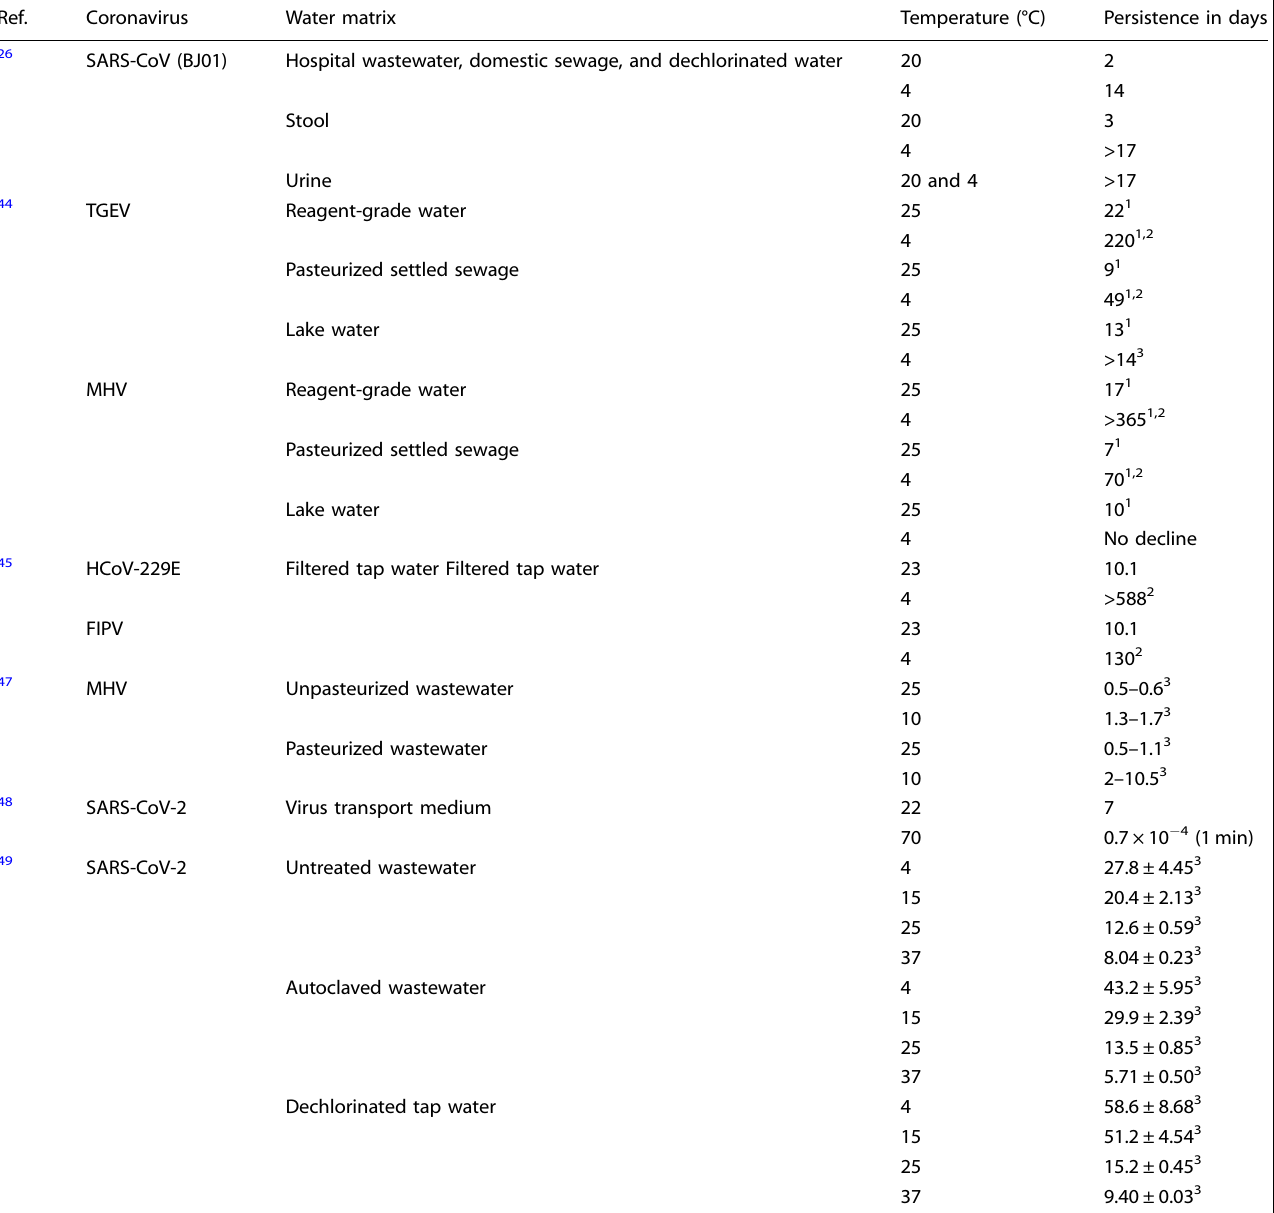
Table 4. The effect of temperature on the persistence of coronavirus in different water matrices.